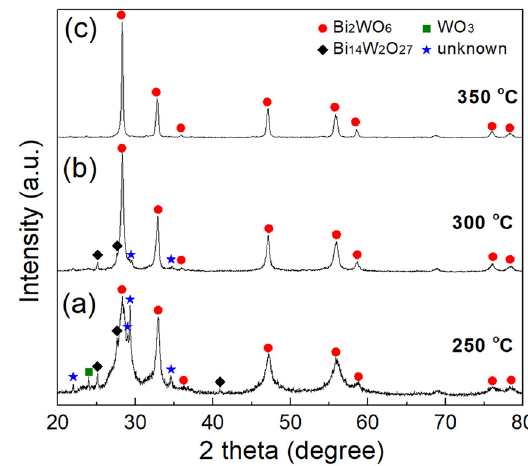
Figure 1. XRD patterns of samples synthesized at different temperatures with a mass ratio of 5:1 for the salt and the precursor.